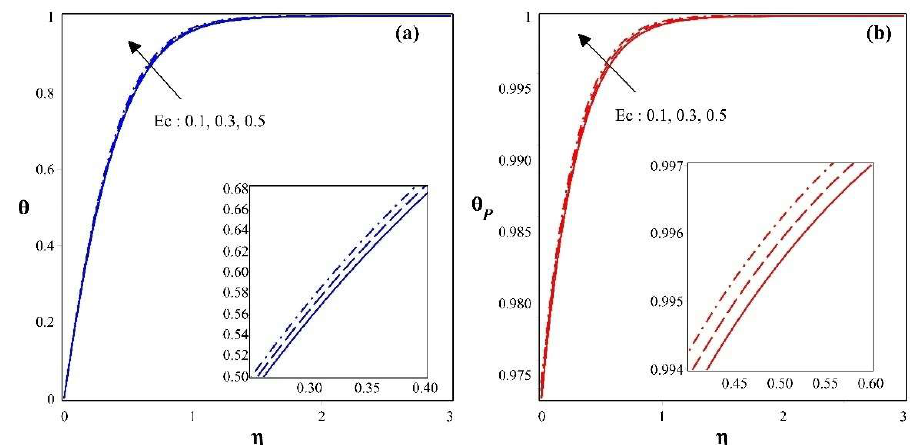
Figure 4. Effect of the porosity parameter on the fluid- and dust-phase velocity profiles.